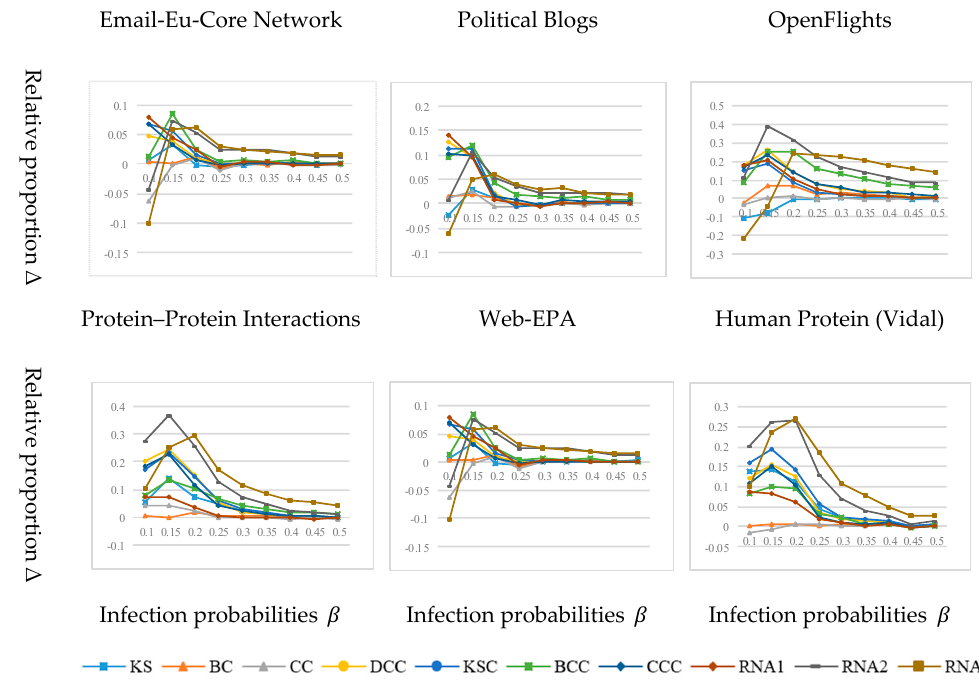
Figure 2. In the single-point contact susceptible-infectious-recovered (SIR) model, the relationship between ∆ and β with 1% nodes in the key node set.